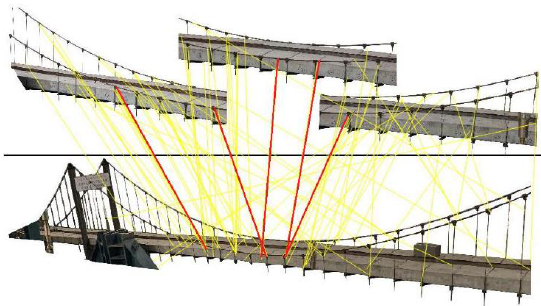
Figure 16. Description of text bridge feature points.